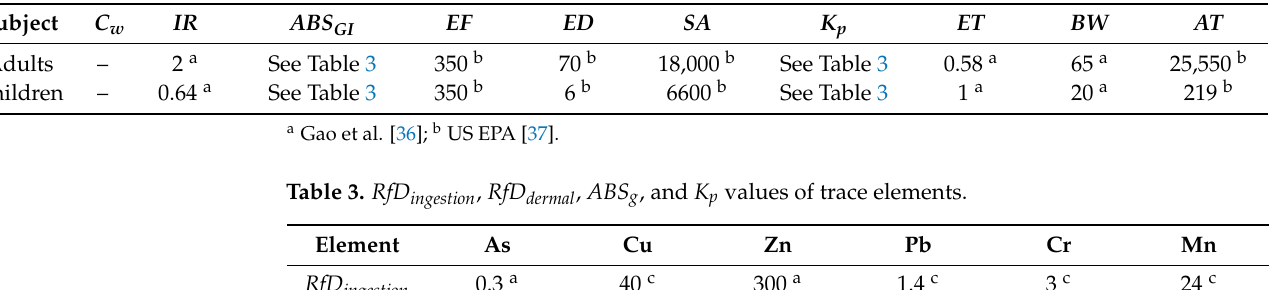
Table 2. Statistics of disclosure parameters.